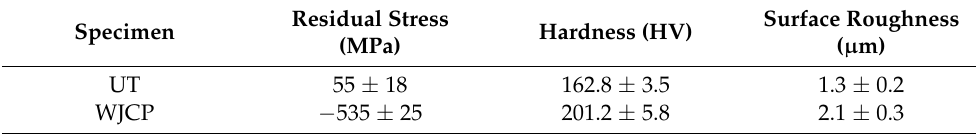
Table 2. WJCP-induced changes in residual stress, hardness, and surface roughness in 600 MA. Specimen